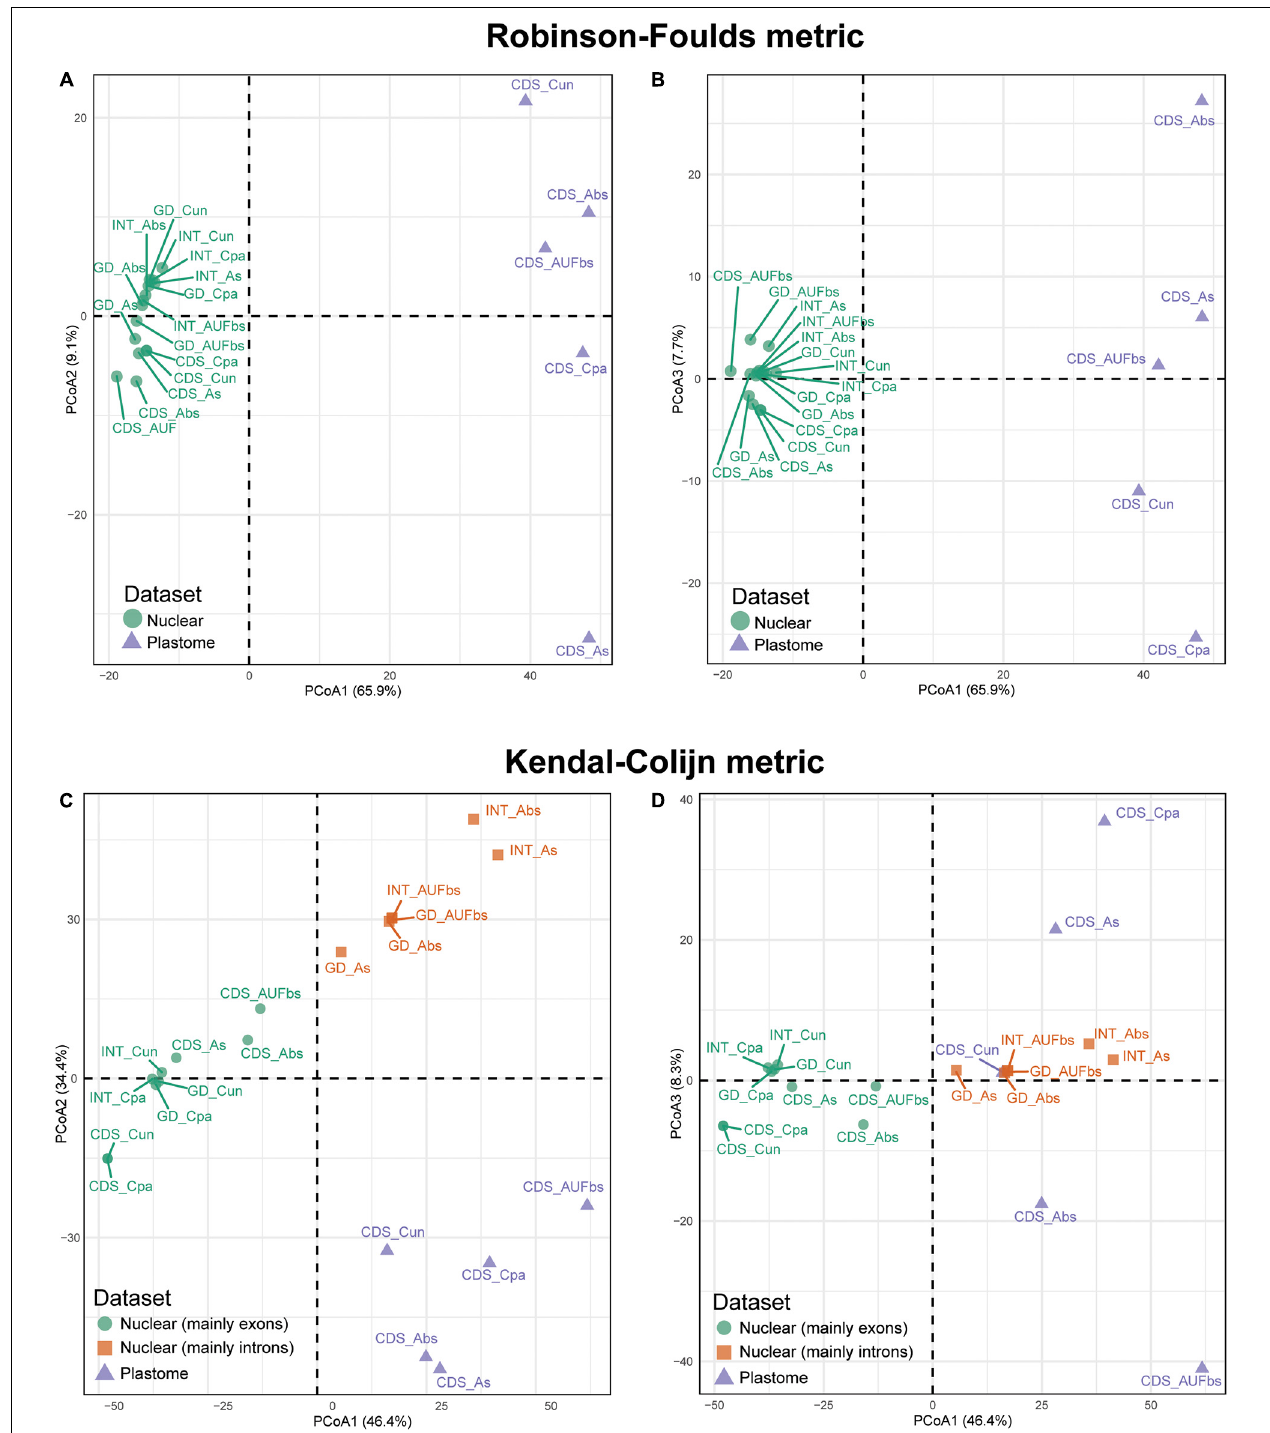
FIGURE 5 | Principal coordinate analysis depicting ordinations of 20 tree topologies of Eugenia using Robinson-Foulds distance metric calculated from rooted trees (A,B) and Kendal-Colijn distance metric inferred from unrooted trees (C,D) . CDS, orthologous sequences of coding regions; INT, splash zone encompassing introns and intergenic DNA that flank target exons; GD, combination of nuclear ncCDS and ncINT; Cpa, concatenated and partitioned ML reconstruction; Cun, concatenated and unpartitioned ML reconstruction; As, coalescent Astral tree with local posterior probability support; Abs, coalescent-based Astral tree with 100 bootstrap replicates; AUFbs, coalescent Astral tree with 1,000 ultrafast bootstrap replicates).